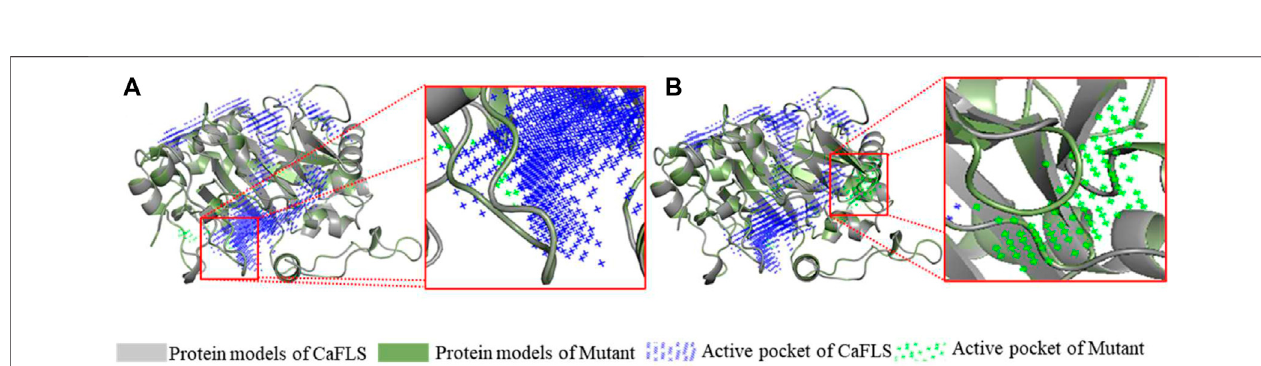
Frontiers in Pharmacology |